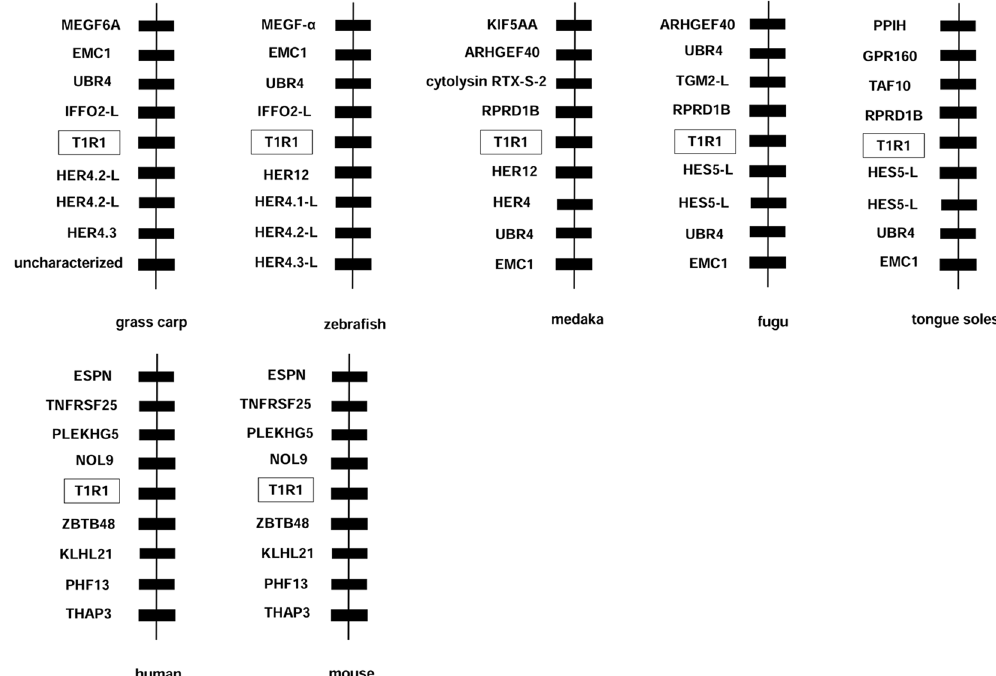
Figure 5. Synteny analyses of T1R1 genes. Adjacent genes of human and mouse T1R1 were strictly conserved. In fish transcription factor genes (hairy-related genes: HER4.1, HER4.2, HER4.3, HER12, hes family bHLH transcription factor 5: HES5) were near T1R1. ER membrane protein complex subunit 1 (EMC1), ubiquitin protein ligase E3 component n-recognin 4 (UBR4) appeared in downstream of T1R1 in medaka, fugu and tongue sole; however, it was located upstream of T1R1 in zebrafish and grass carp. Upstream genes of T1R1 in grass carp were similar as in zebrafish. The regulation of nuclear pre-mRNA domain containing 1B (RPRD1B) was present upstream of T1R1 in medaka, fugu and tongue sole but not in zebrafish and grass